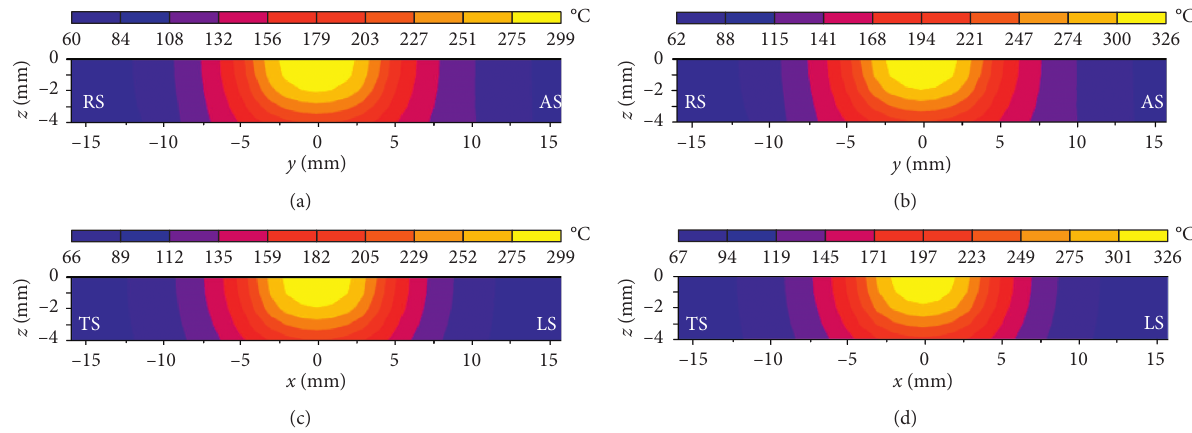
Figure 16: The predicted temperature distributions on different sections in the pin-plunging stage. (a) Transverse section in the CAM. (b) Transverse section in the MAM. (c) Longitudinal section in the CAM. (d) Longitudinal section in the